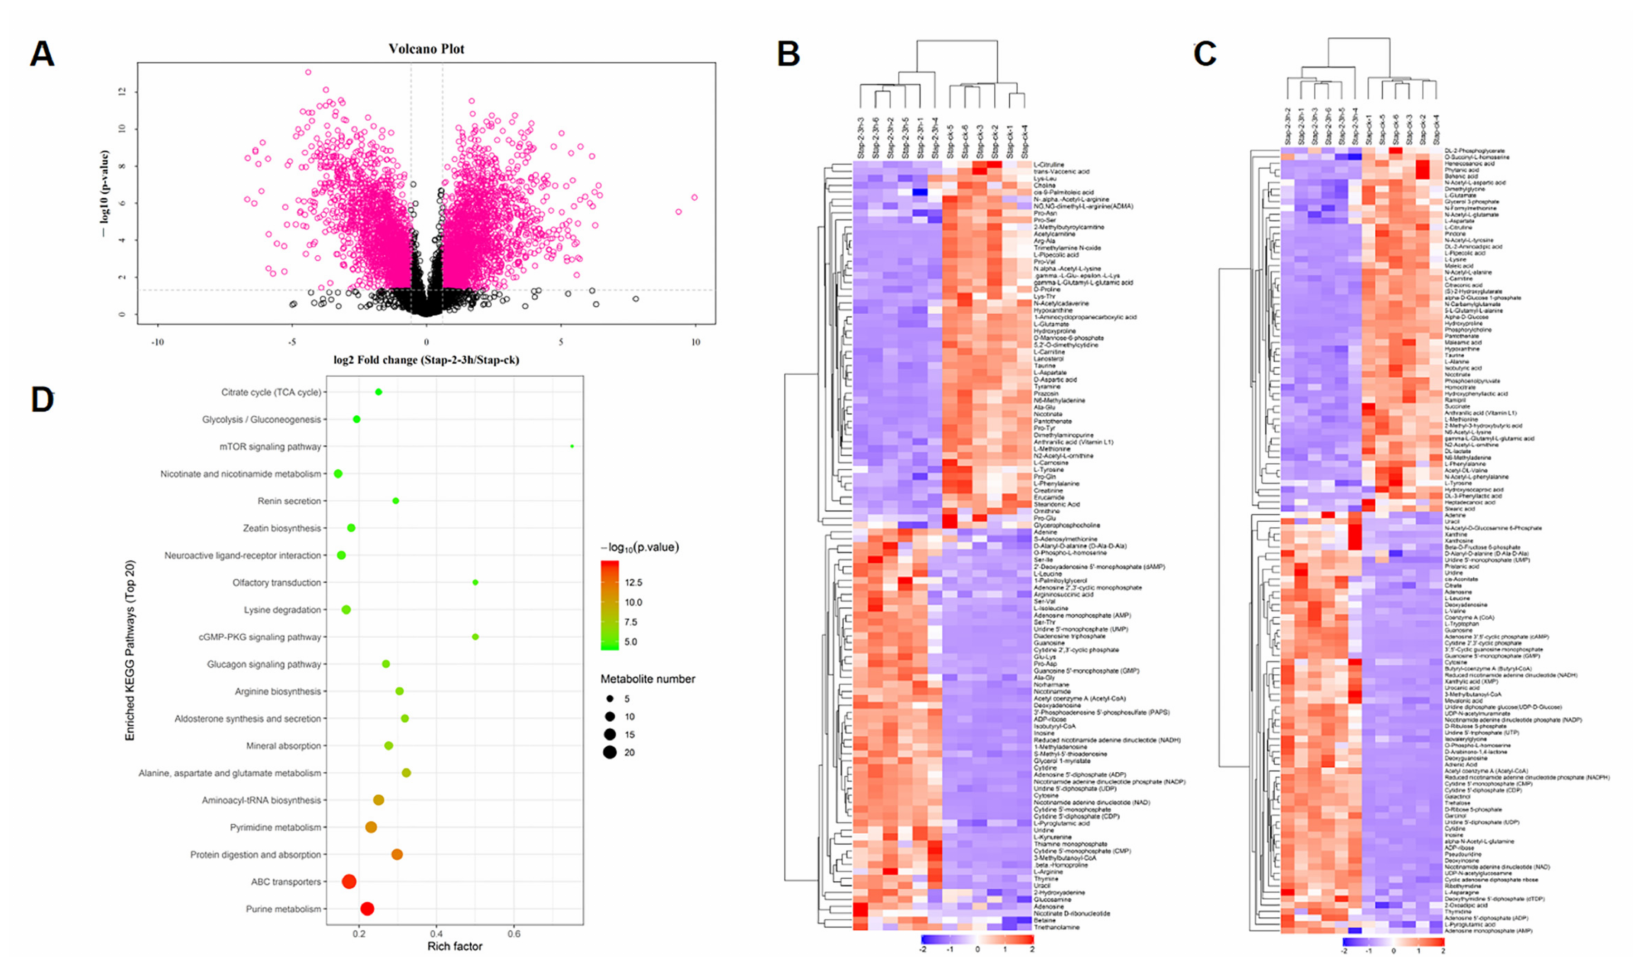
Figure 4. Metabolites results of S.aureus treated with actinomycin D. ( A ) Volcano plot of significantly differently metabolites. ( B ) Hierarchical cluster heat map of differentiated metabolites in positive mode. ( C ) Hierarchical cluster heat map of differentiated metabolites in negative mode. ( D ) Top 20 pathways encompassed by the differentiated metabolites. Color represents p -value; a red color represents low p -value, a green color represents high p -value; the pathways showing a red color are significantly altered, and the circle size represents the gene